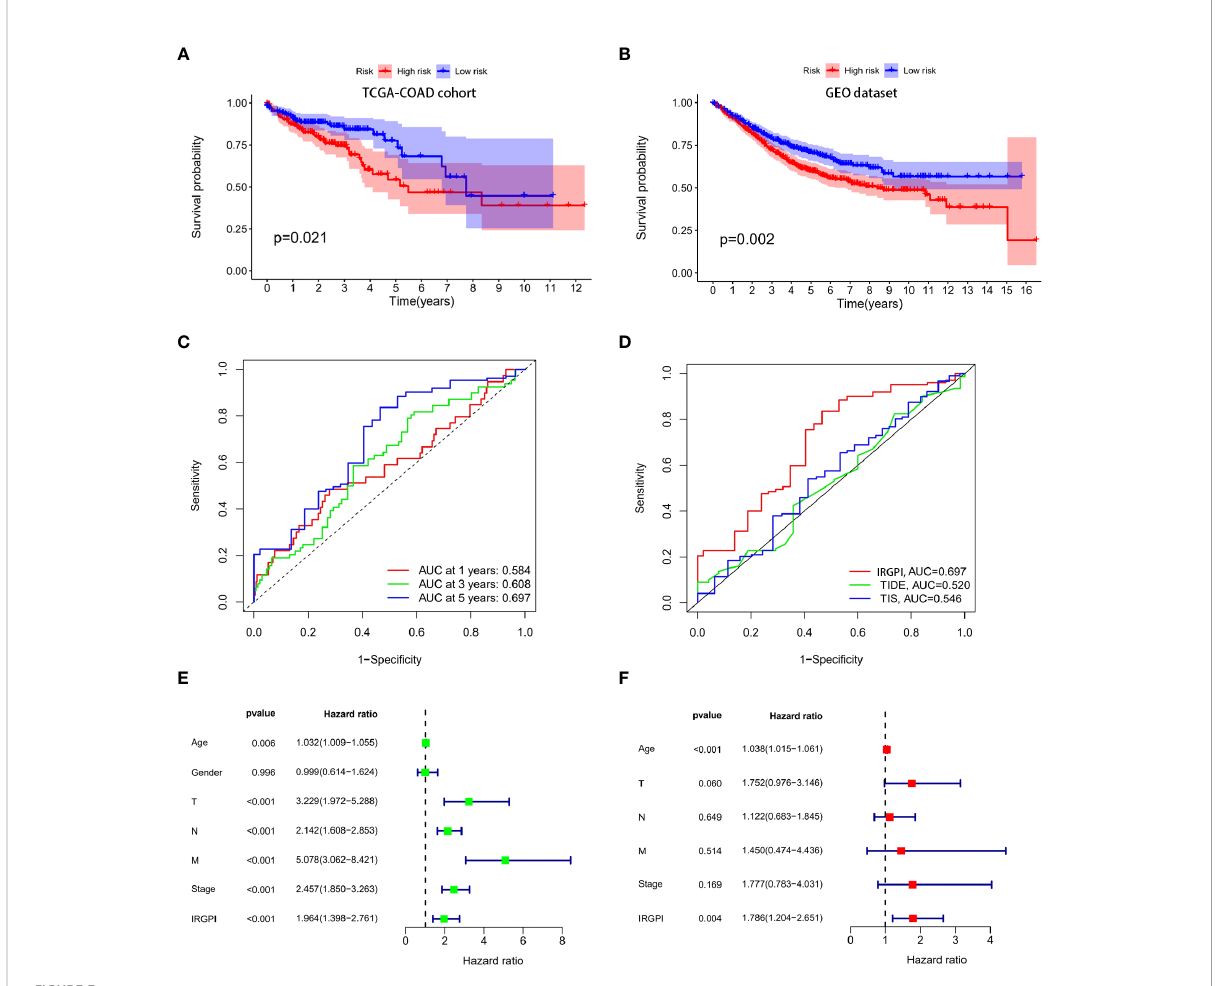
FIGURE 3 Construction and validation of immune-related prognostic index (IRGPI) model. IRGPI model was constructed using the multivariate cox proportional hazards model. Patients in the TCGA-COAD cohort were used as training set and patients in the GEO cohort were used as the validation set. ROC curves were plotted and AUCs were calculated to estimate the power of the IRGPI model to predict prognosis. (A) Survival of colon patients in high-risk and low risk groups in the TCGA-COAD cohort. Patients in the high risk group showed worse survival than patients in the low risk group. (B) Survival of colon patients in high-risk and low risk group in the GEO cohort. Patients in the high risk group showed worse survival than patients in the low risk group. (C) ROC curves of the IRGPI model for 1-year, 3-year and 5-year. The AUCs of ROC for 1- year, 3-year and 5-year were 0.584,0.608 and 0.697, respectively. (D) ROC curves of IRGPI model, TIS model and TIDE model for 5-years. The IRGPI model showed a stronger predictive power than the TIS and TIDE model. (E) Univariate cox regression analysis showed that IRGPI was correlated to survival. (F) Multivariate cox regression analysis showed that IRGPI was an independent prognostic factor for